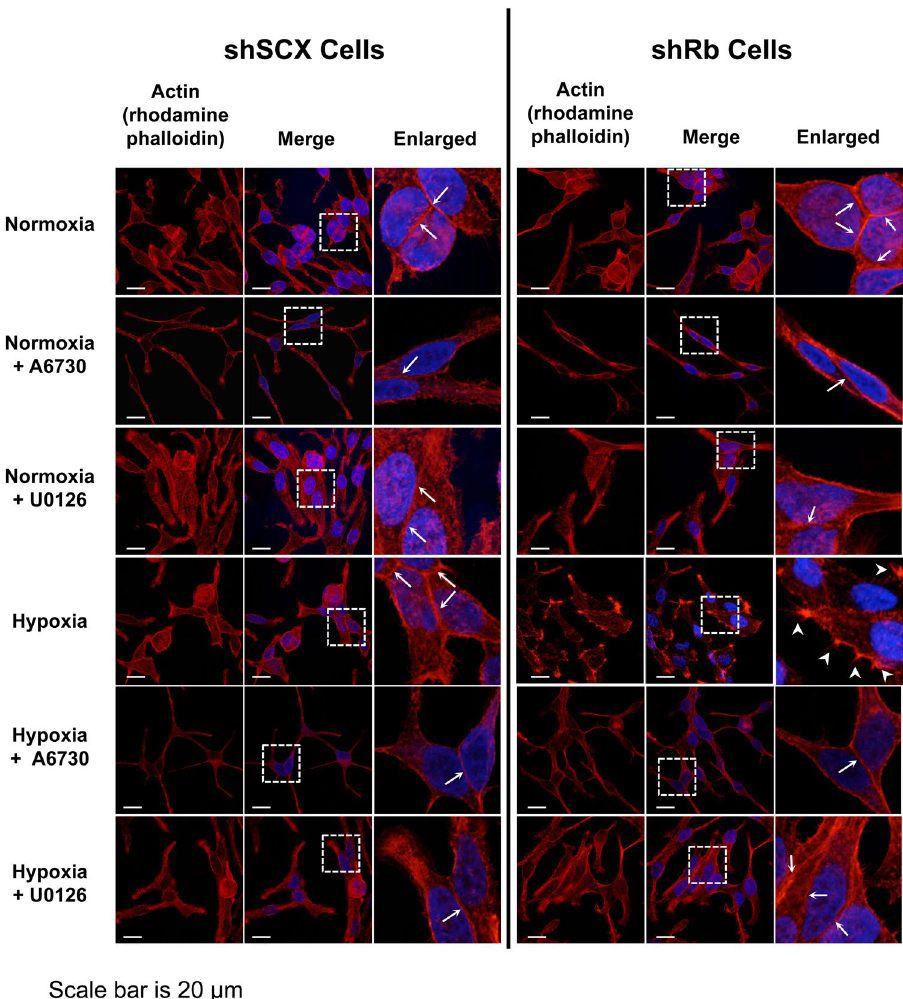
Figure 5. Immunofluorescence microscopy of actin in LNCaP cells. shRb and shSCX LNCaP cells were exposed to 72 h of hypoxia or normoxia and treated with or without 10 µ M U0126 or 2 µ M A6730. Fixed cells were treated with DAPI and TRITC-labelled rhodamine phalloidin and were imaged with a Zeiss LSM-780 confocal microscope. Phalloidin only images are represented in the left panels, merged images are in the middle panels and enlarged merged images are represented in the right panels. Filopodia-like processes are highlighted with large white arrow heads and cell:cell actin borders are shown with white arrows. Each experiment was repeated four